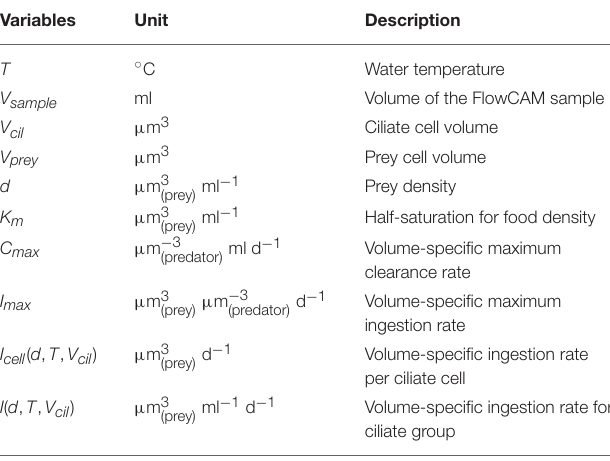
TABLE 2 | Variables used for estimating ciliate grazing rates in Eq. 1–6.